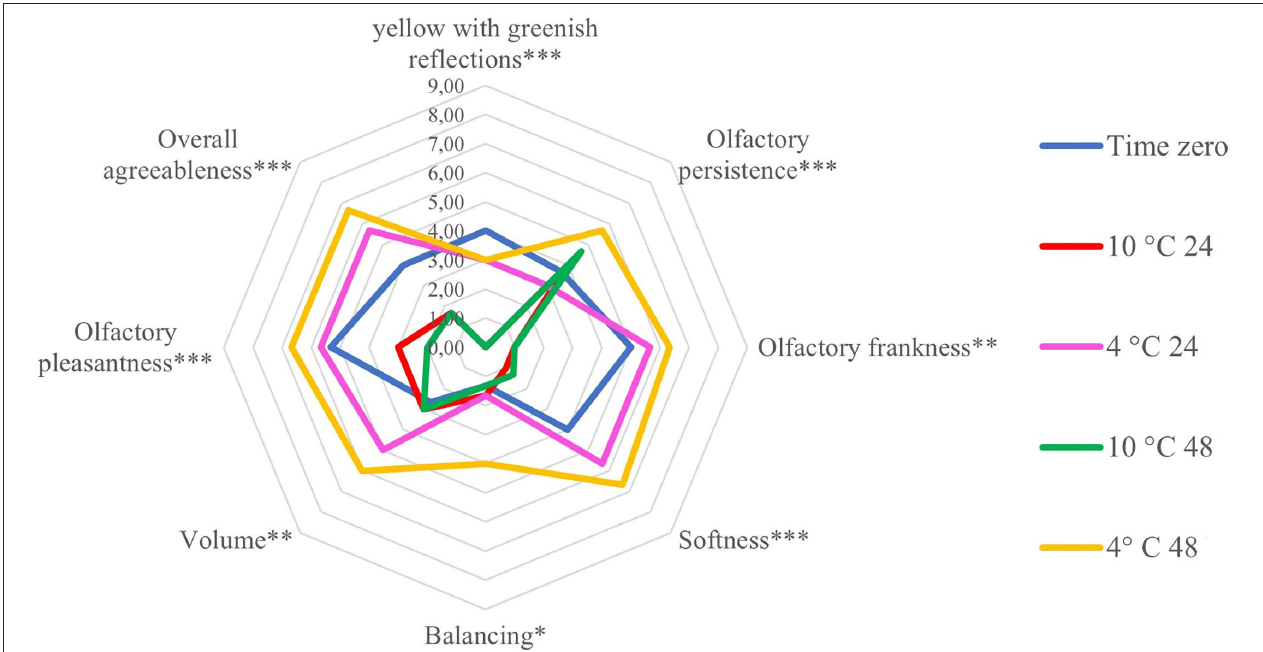
FIGURE 6 | Sensorial parameters (yellow with greenish reflections, olfactory persistence, olfactory frankness, softness, balancing, volume, olfactory pleasantness, and overall agreeableness) of wines at the end of alcoholic fermentation. Wines were made from Vermentino grapes at the harvest (Time 0) and following cooling treatment at 4 and 10 ◦ C for 24 and 48h. Asterisks represent statistically significant differences (*** p < 0.001; ** p < 0.01; * p < 0.05) based on ANOVA and Tukey post-hoc test performed between treatments and T0